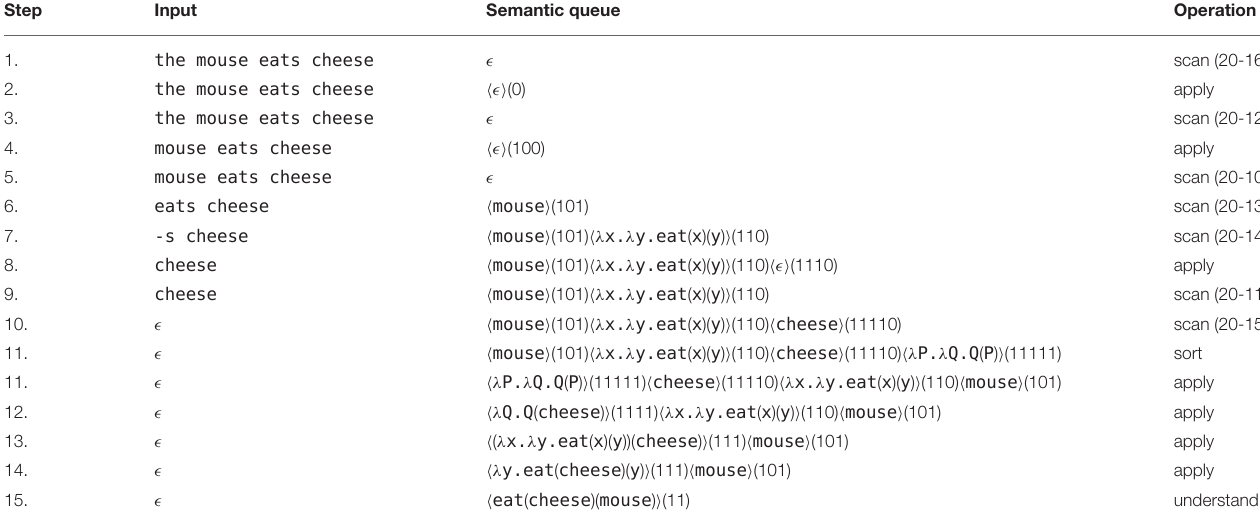
TABLE 4 | Semantic processing of the mouse eats cheese